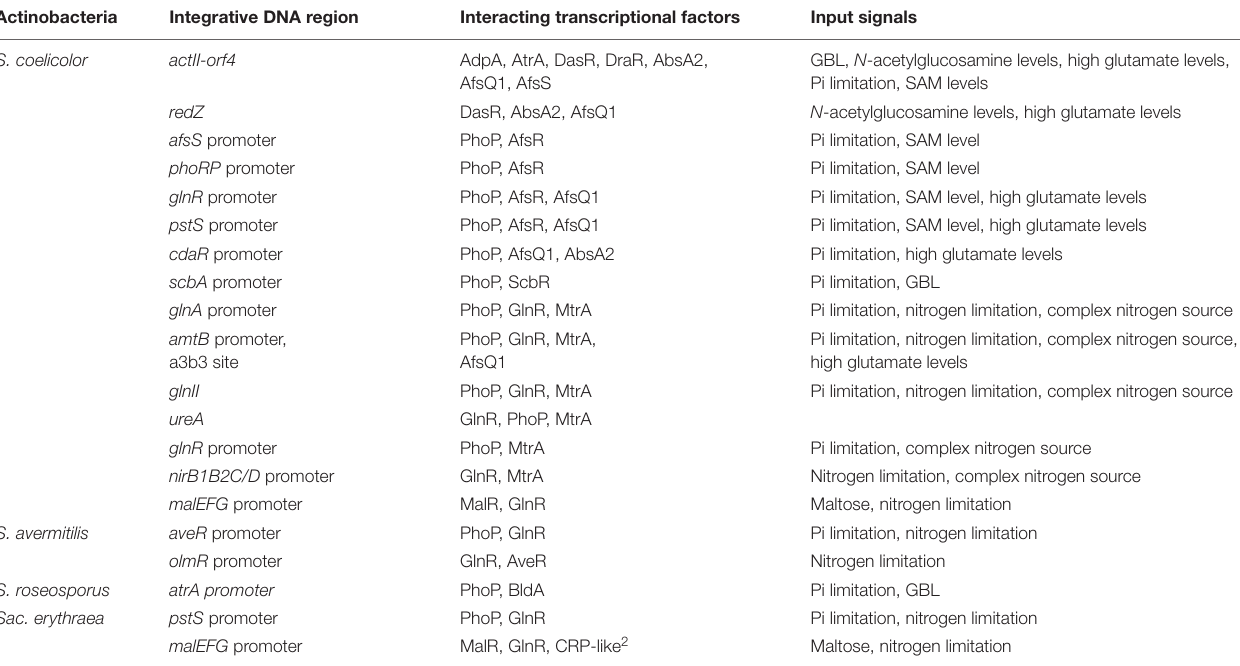
TABLE 1 | Well-known examples of interacting transcriptional factors in Actinobacteria 1